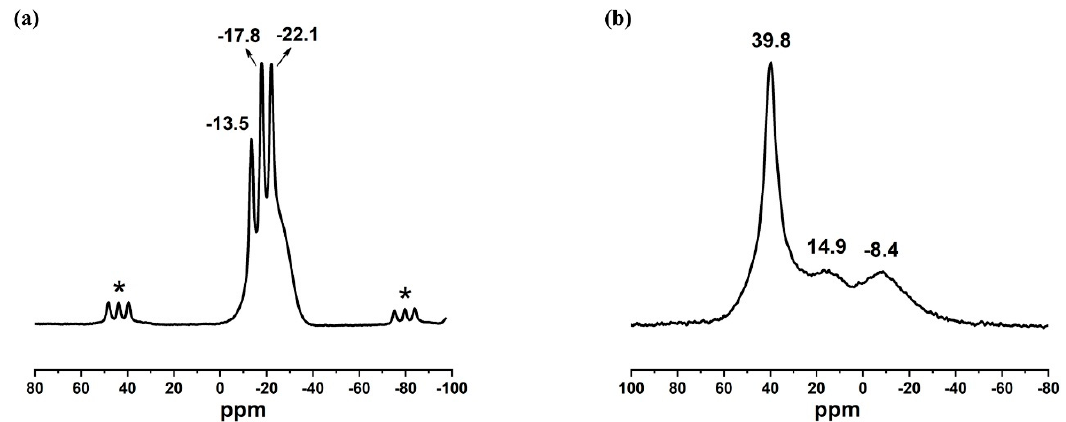
Figure 3. ( a ) 27 Al magic angle spinning (MAS) NMR spectra of SYSU-6; ( b ) 31 P MAS NMR spectra of SYSU-6. Asterisks ( * ) denote the spinning sidebands.